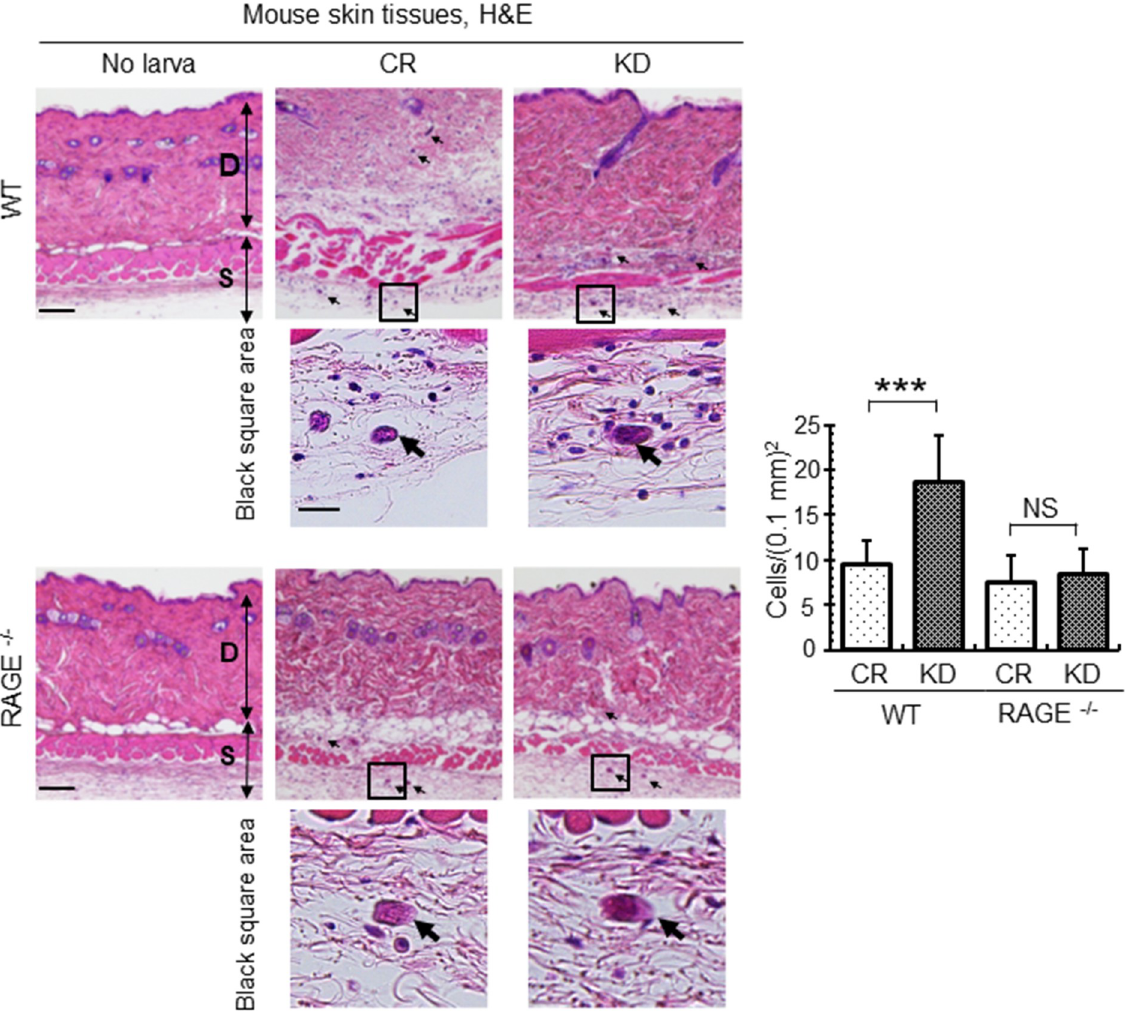
Fig 8. Endogenous venestatin prevented accumulation of inflammatory cells in mouse skin tissues. Histochemical analysis of skin tissues from wild-type (WT) or RAGE-null (RAGE -/- ) mice was performed. The skin tissues were collected from the larva inoculation site at 6 h p.i. with 2,000 LL3s treated with ds luciferase (CR) or ds venestatin (KD). The sections were subjected to H&E staining, and cells around the larvae (arrows) were then counted. Black square: high-magnification image around larvae. D, dermal tissue; S, subdermal tissue. Scale bar: 40 μ m. Data are expressed as means ± SDs of 12 fields from two mice. ��� p < 0.0001. NS, no significant